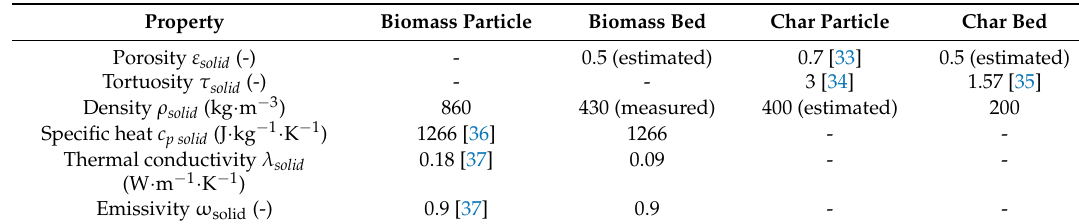
Table 7. Physical properties of biomass and char particles and beds.